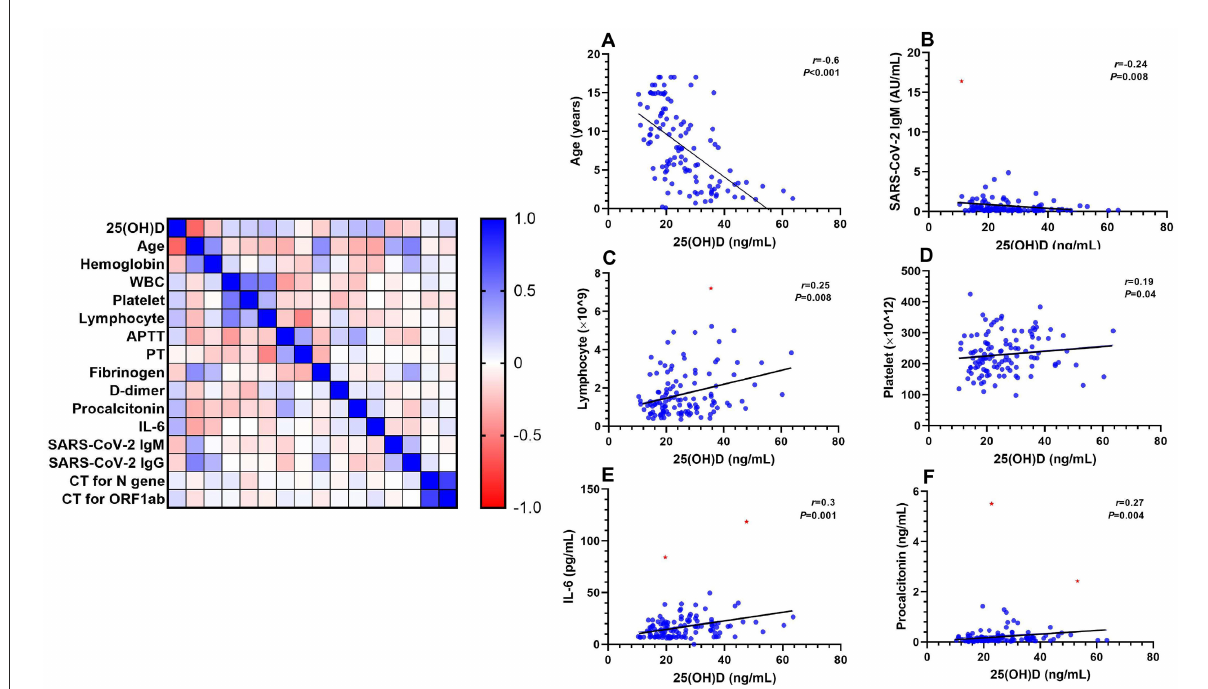
FIGURE2 Spearman correlation analysis of serum 25(OH)D concentrations with other clinical parameters, r represents the correlation coefficient. The red dots in B, C, E, F represent outliers. APTT, activated partial thromboplastin time; CT, cycle threshold; IL-6, interleukin-6; PT, prothrombin time; WBC, white blood cell. (A) age; (B) SARS-CoV-2 IgM; (C) lymphocytes; (D) platelets; (E) IL-6; (F) procalcitonin. Equation: (A) Y = − 0.276 * X + 15.1; (B) Y = − 0.03 * X + 1.51 (Outlier included); Y = − 0.012 * X + 0.88 (Outlier excluded); (C) Y = 0.035 * X + 0.81 (Outlier included); Y = 0.031 * X + 0.86 (Outlier excluded); (D) Y = 0.76 * X + 212; (E) Y = 0.38 * X + 7.85 (Outliers included); Y = 0.25 * X + 9.8 (Outliers excluded); (F) Y = 0.006 * X + 0.11 (Outliers included); Y = 0.003 * X + 0.13 (Outliers excluded).